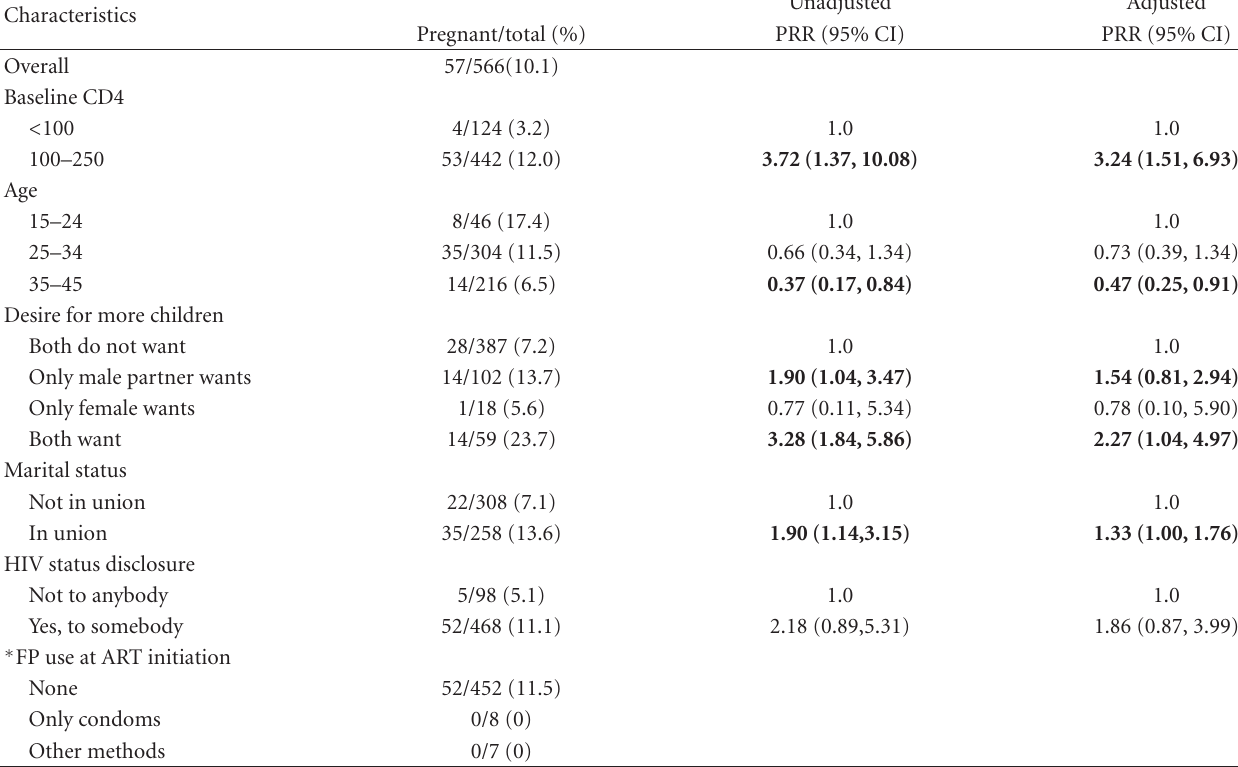
Table 4: Prevalence of pregnancy, unadjusted and adjusted PRR among HIV women at time of initiating ART. Characteristics